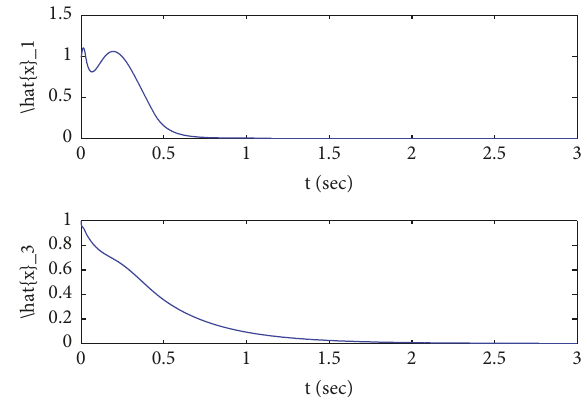
Figure 3: The time response of states ̂𝑥 1 , ̂𝑥 3 of system (26) with ̂𝑥 (0) = 1, ̂𝑥 (0) = 1 3